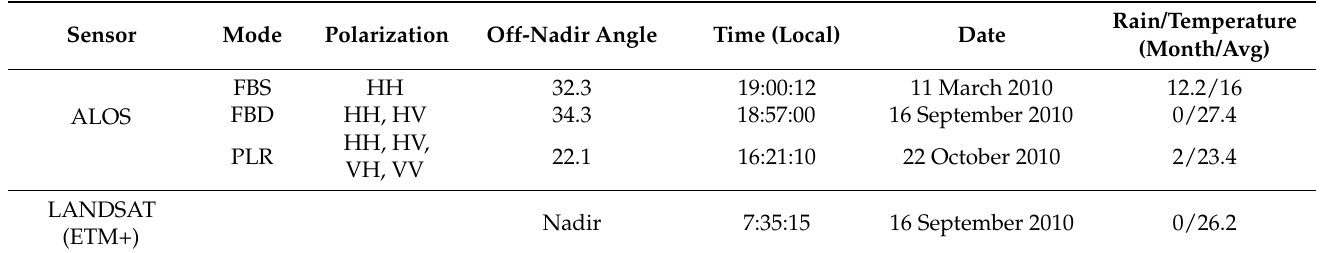
Figure 1. Test site location using Landsat RGB image and soil sample points in the northern part of Iran. Table 2. The satellite dataset used in this research and monthly average of